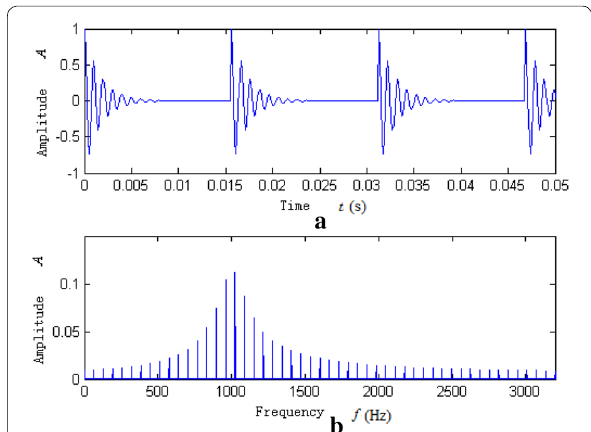
Figure 7 Response 1 (natural frequency: 1000 Hz, phase: 0°): ( a ) time waveform, ( b ) FFT spectrum